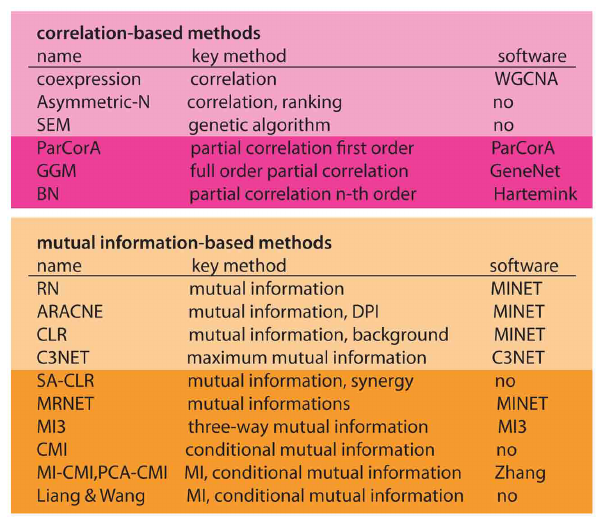
FIGURE 6 | Overview of inference methods to reconstruct regulatory networks from expression data. First column, name of the method. Second column, methodological base of the method.Third column, name of the software package, if available. Horizontal classification, first panel, linear methods (correlation-based). Second panel, non-linear methods (information-based). Darker colors represent extended